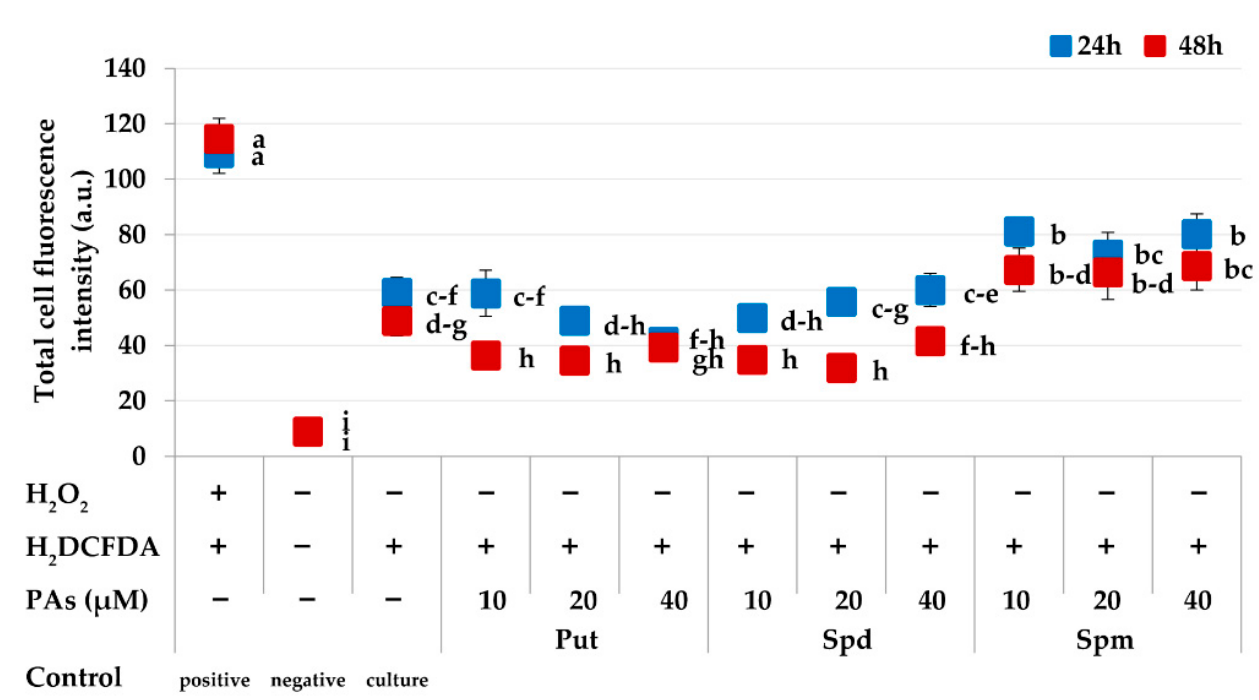
Figure 3. Detection of reactive oxygen species (ROS) in Brassica oleracea L. var. capitata protoplast cultures using H 2 DCFDA. Measurements were based on the quantification of the fluorescence intensity. The points represent the means ± SE ( n = 80). The green and red points should be considered separately. Means followed by the same letter were not significantly different ( p ≤ 0.05, Duncan’s multiple range test (MRT)). Description of the x -axis: “+“ means the treatment was applied “ − “ means no treatment. The polyamines (PAs) are as follows: putrescine (Put), spermidine (Spd), and spermine (Spm).